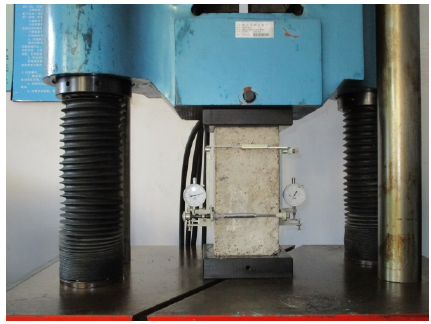
Fig ure 5. Modulus of elasticity test. Figure 5. Modulus of elasticity test.